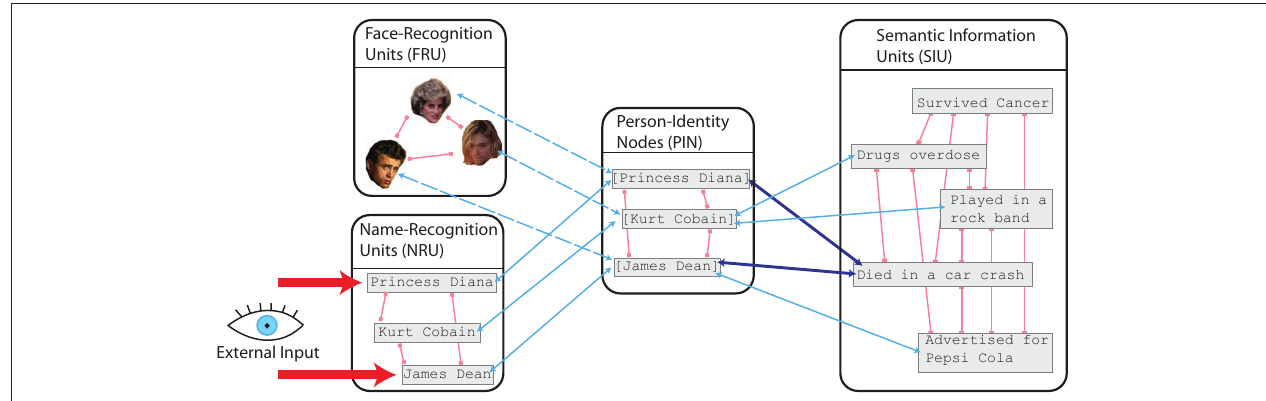
Figure 1 | interactive activation and competition (iAC) model. Red lines are inhibitory connections, blue arrows are excitatory. Note that access to the semantic information is routed exclusively via the